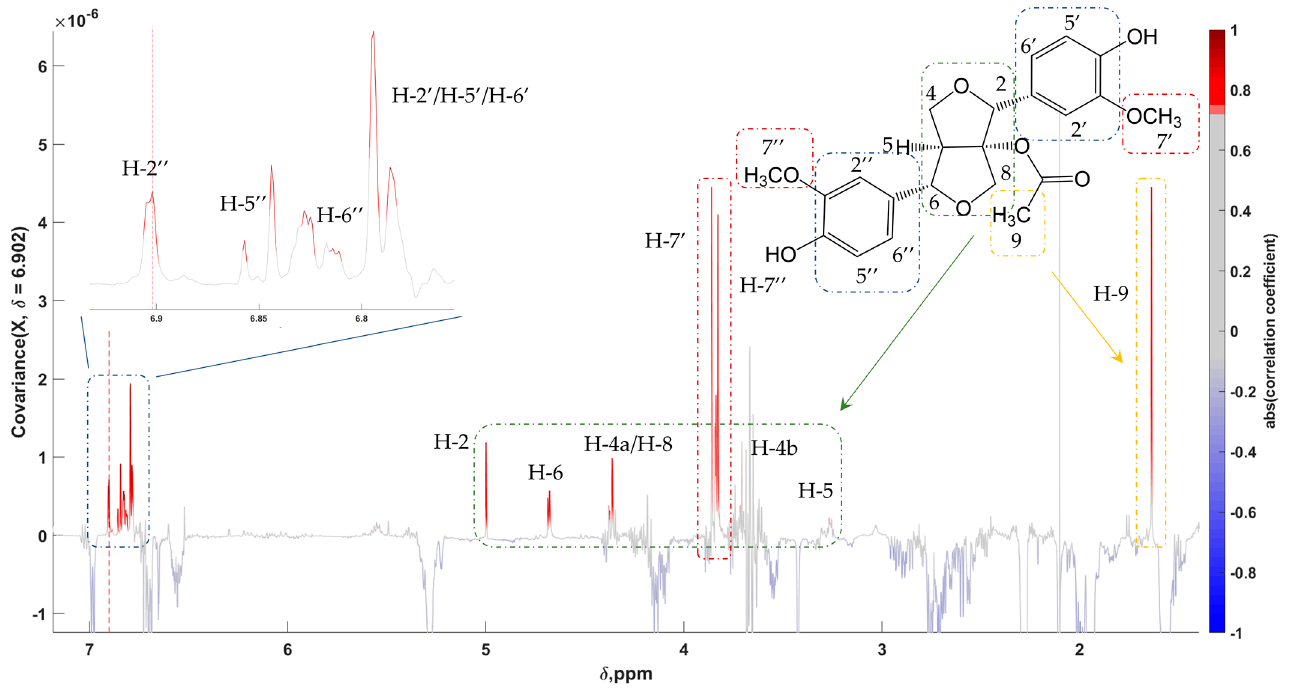
Figure 7. STOCSY 1D pseudo-NMR spectrum of acetoxypinoresinol. Correlation coefficients to the other signals in the median EVOO NMR spectrum are color-encoded: the “driver peak” was at 6.902 ppm. Zoom-in of the aromatic regions is also presented.